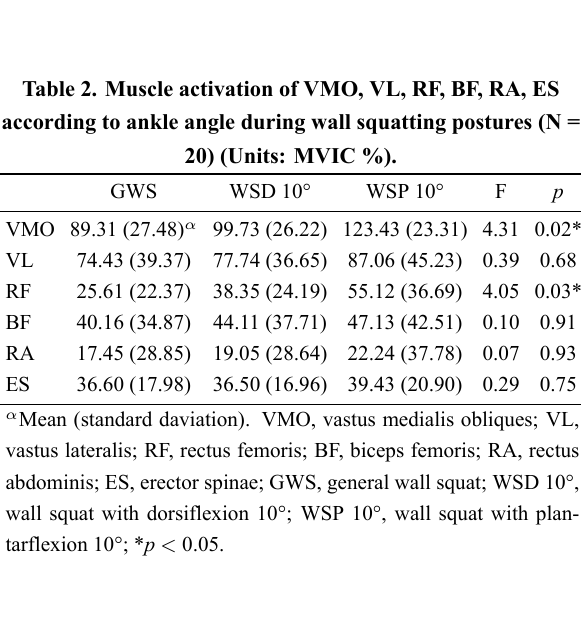
Table 2. Muscle activation of VMO, VL, RF, BF, RA, ES according to ankle angle during wall squatting postures (N = 20) (Units: MVIC %).